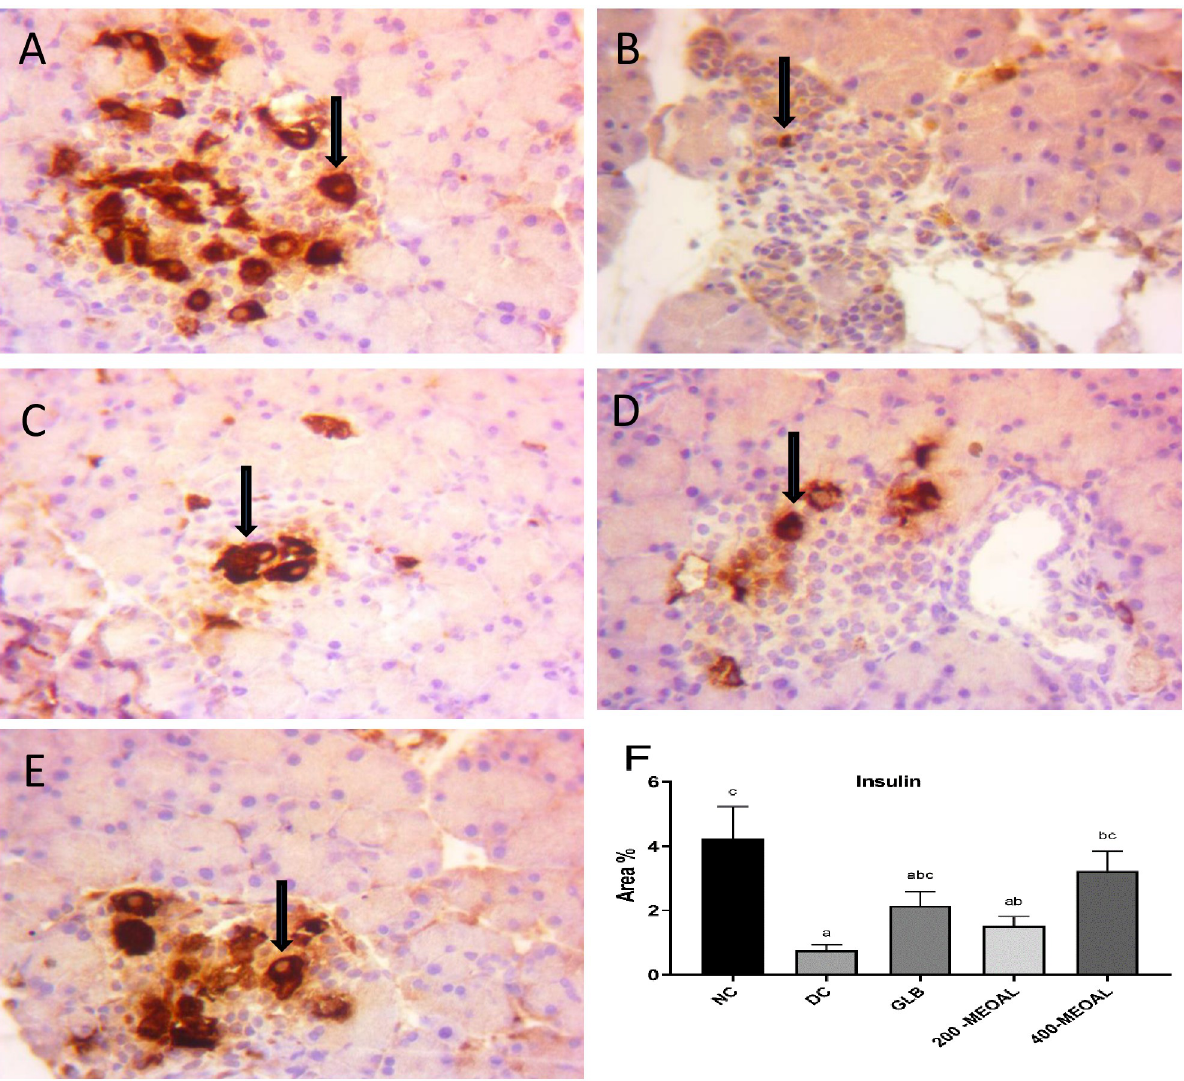
Fig 5. Effect of GLB or MEOAL on insulin changes in the islets of Langerhans in different groups. Anti-insulin Immunohistochemical staining (40 X). https://doi.org/10.6084/m9.figshare.21828864.v1. Pancreatic section from; (A) normal control group showing normal distribution of the insulin that occupies the center of the islet (arrow); (B) Diabetic control group showing marked reduction in the immunohistochemical expression of insulin in β -cells (arrow) compared to NC (P < 0.05,F); (C) Diabetic GLB(5mg/kg) treated group showing an increase in insulin content of β -cells compared to DC (P > 0.05,F); (D) Diabetic MEOAL (200mg/kg) treated group showing an increase of positive reactivity of insulin in the cytoplasm of β -cells (arrow) compared to DC(P > 0.05,F); (E) Diabetic MEOAL (400mg/kg) treated group showing significant increase in the expression of insulin in β - cells (arrow) compared to DC (P < 0.05,F). F: The bar chart represents anti-insulin immunopositive staining expressed as area%. The results are expressed as mean ± ± SEM (n = 8). P-value was calculated using ANOVA with Post Hoc Tukey test. The same letters mean no significant difference, the different letters (a, b, c) mean a significant difference at P < 0.05. Abbreviations: NC; normal control group. DC; diabetic control group. GLB; 5mg/ kg glibenclamide treated group .200or 400- MEOAL; 200 or 400mg/kg O . acanthium extract treated groups respectively. The various binding free energy values of studied compounds showed in (Table 1) (-5.2 to Cyclooxygenase active site of COX-2 and Cyclooxygenase-1 COX-1, respectively. As a result of maximum binding score of -9.2 kcal/mol, Catechin was the most effective docked compound against (PDB:1CVU). Catechin interacts through a hydrogen bond with Asn 39, Asn 43, Gln